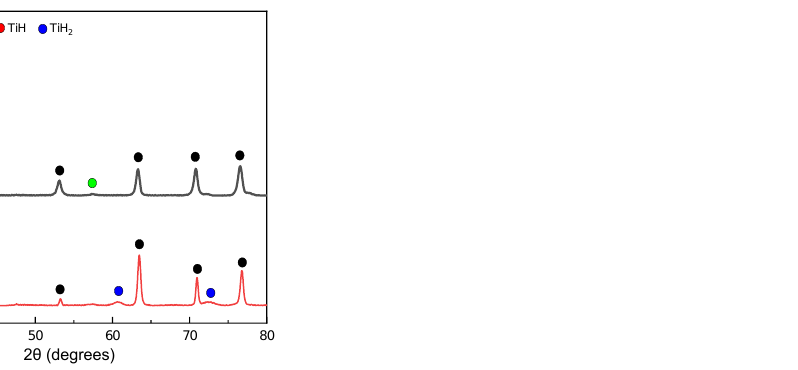
Figure 2. XRD patterns of Ti6Al4V alloy before and after hydrogen charging for 1 h in 3.5 wt.% NaCl solution.